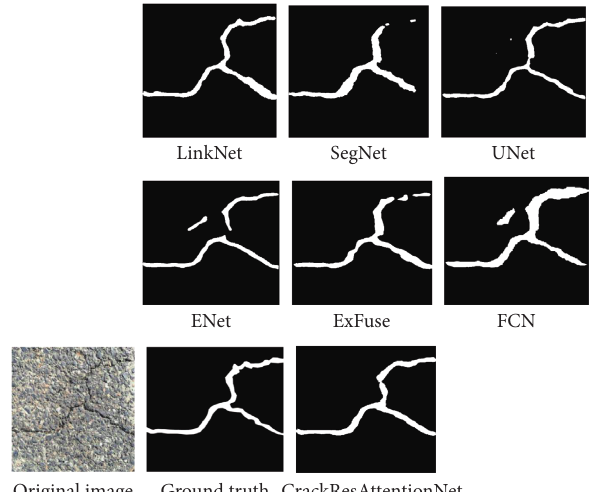
Figure 9: Yantai Dataset Sample Prediction-BCE loss.